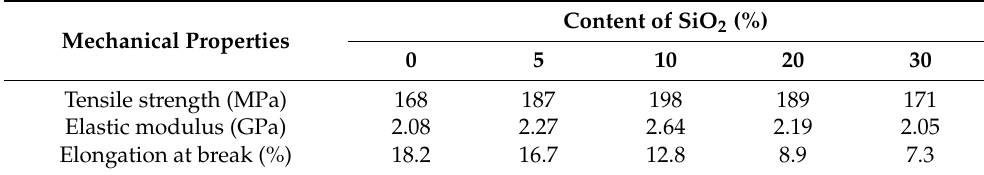
Table 1. The mechanical properties of PI/SiO 2 films with various SiO 2 contents. Mechanical